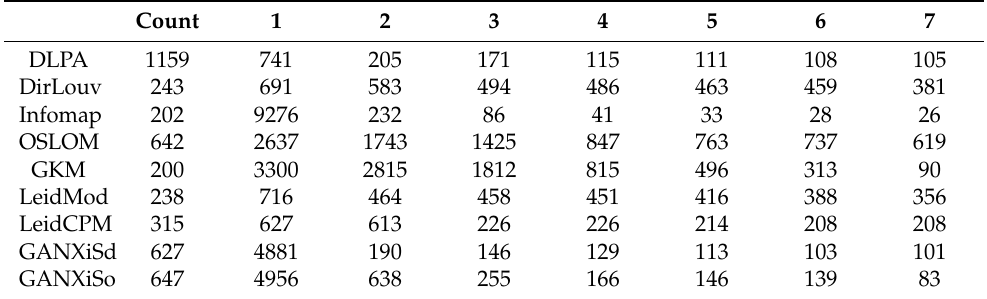
Table 2. The number of communities obtained on the Biryulevo dataset and the value of the seven largest of them for each